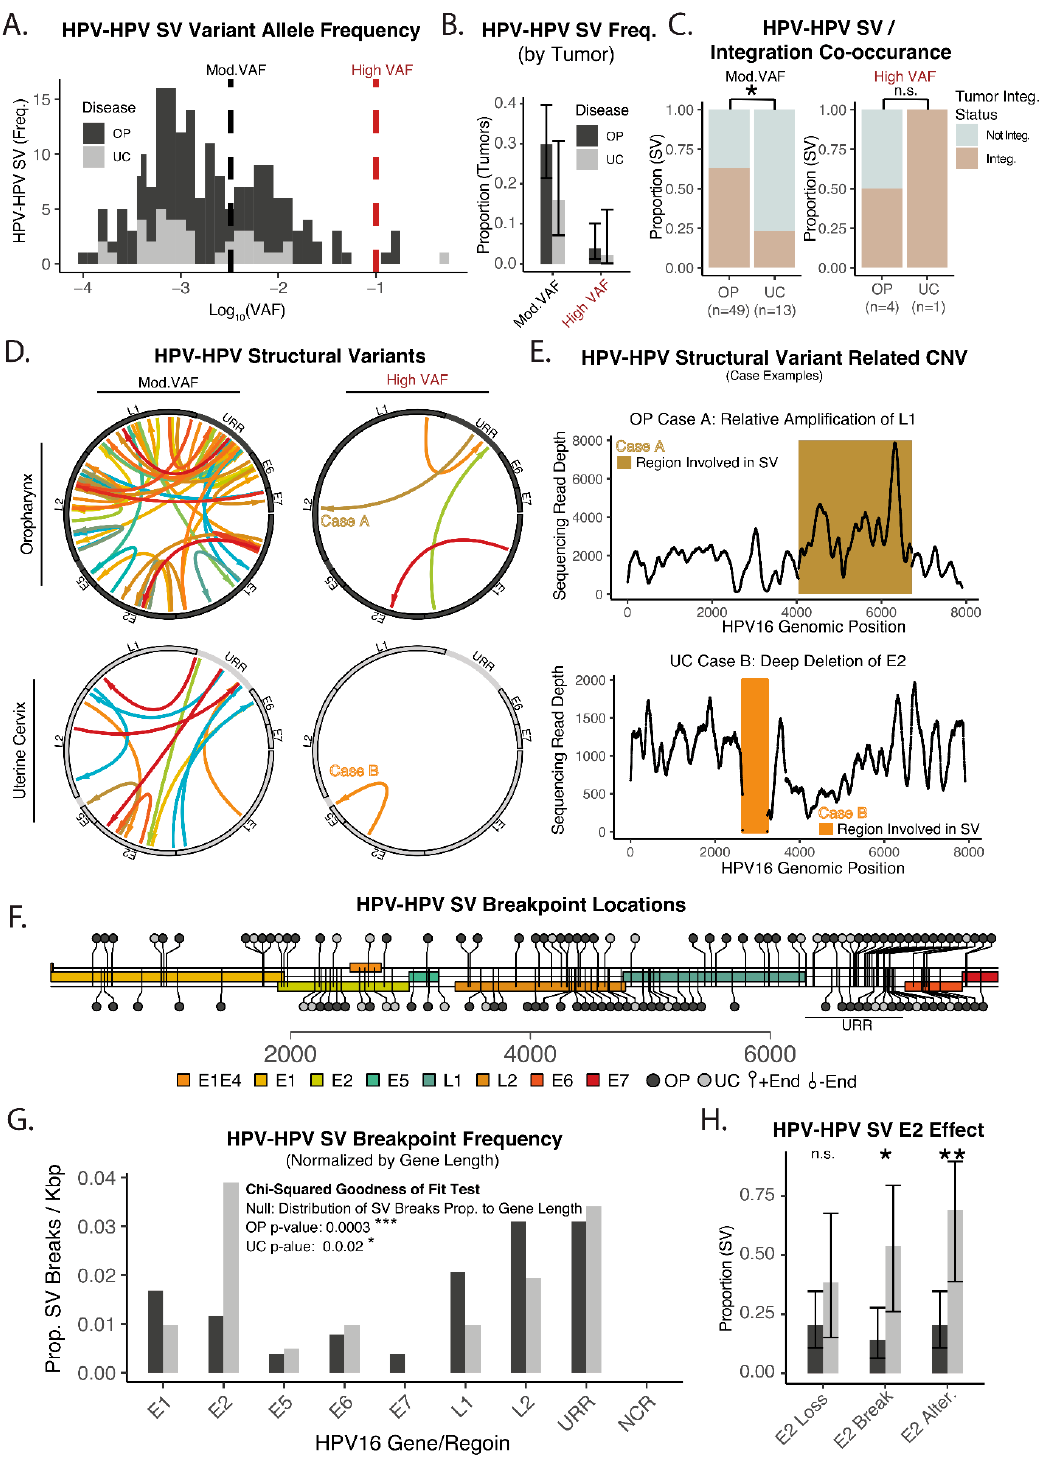
Figure 4. Structural variants in the HPV16 genome in OPSCC and UCSCC. ( A ) Histogram—estimated variant allele frequency (VAF) of HPV–HPV structural variants (SVs). High-quality variant calls were investigated based on empiric VAF thresholds indicated. Black dashed line—moderate